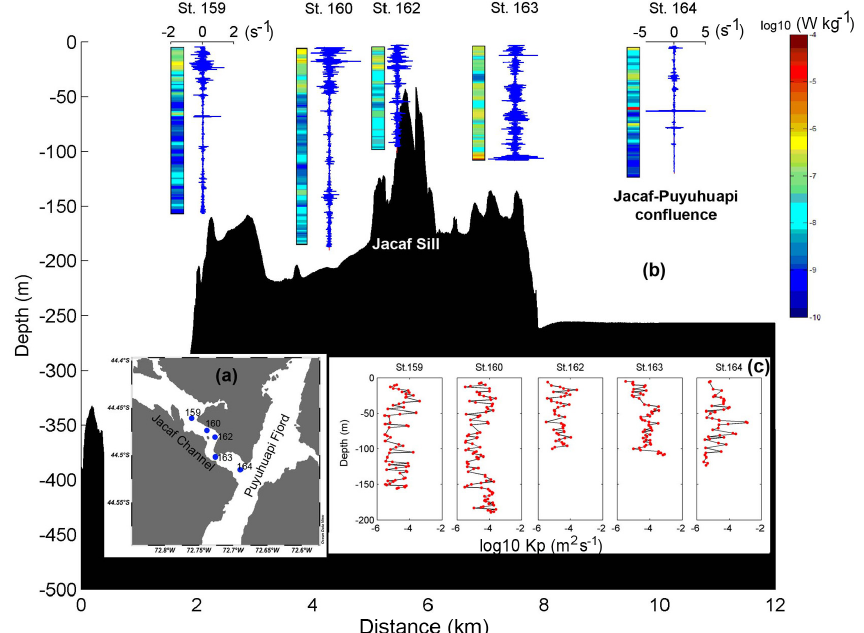
Figure 12. (a) Microstructure profile locations along Jacaf Channel and sill using VMP-250 in November 2013. (b) The color bar showed the dissipation rate of turbulent kinetic energy ( ε ) and the blue lines depict the velocity shear at each station location along Jacaf Channel (as shown in (a) ). The horizontal scale ( − 2 to 2s − 1 ) applied to profiles at stations 160, 162 and 163. Station 164 is located at the confluence of Jacaf Channel and Puyuhuapi Fjord (10.5km). (c) The diapycnal eddy diffusivity profiles ( K p ), obtained at each station shown in (a) .